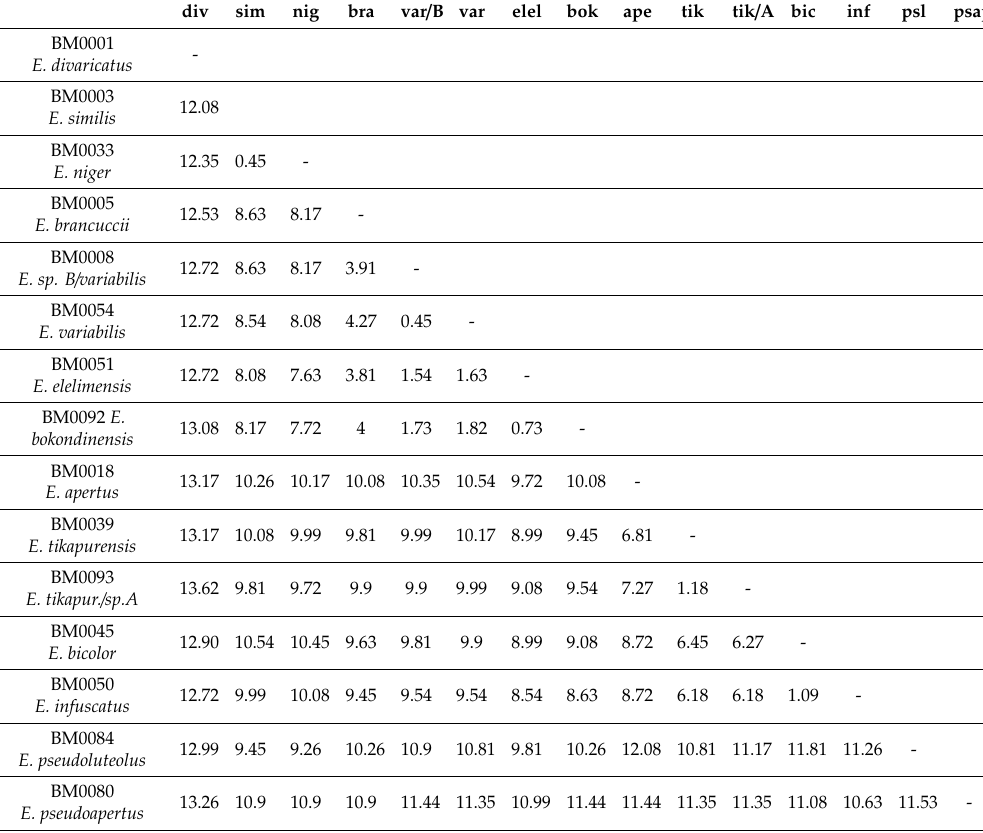
Table 3. The cox1 mtDNA uncorrected pairwise distances among species-rank lineages. The designation after slash refers to the mtDNA and morphology defined species. The highlighted values designate genetic distances within clades of closely related species and population (see Figure 3 and text for the reference on the clades A–C). Abbreviations in the top line are derived from the species names in the second column. If two species designations are given, they refer to mtDNA and RAD-based species limits, respectively (See Figure